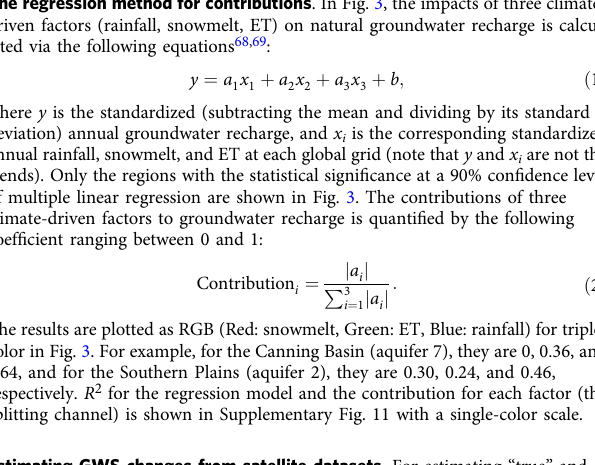
The results are plotted as RGB (Red: snowmelt, Green: ET, Blue: rainfall) for triplet color in Fig. 3. For example, for the Canning Basin (aquifer 7), they are 0, 0.36, and 0.64, and for the Southern Plains (aquifer 2), they are 0.30, 0.24, and 0.46, respectively. R 2 for the regression model and the contribution for each factor (the splitting channel) is shown in Supplementary Fig. 11 with a single-color